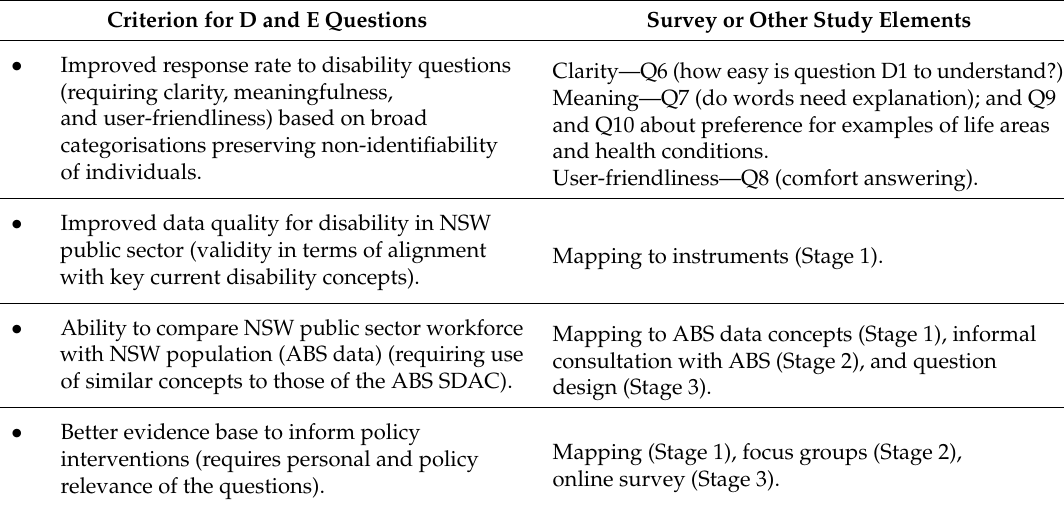
Table 2. Project elements to ensure project criteria